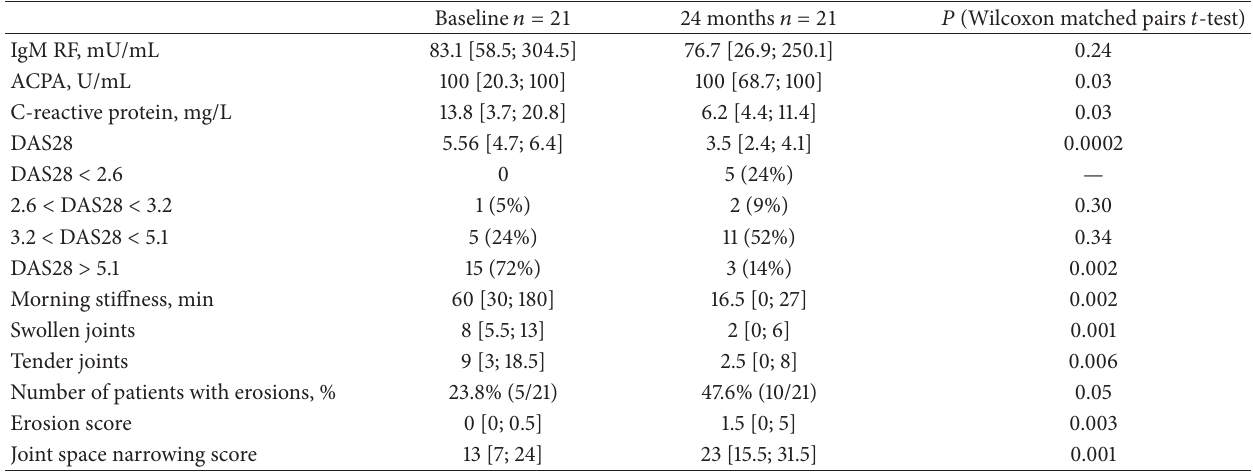
Table 3: Clinical, immunological, and radiological parameters and therapeutic response in seropositive rheumatoid arthritic